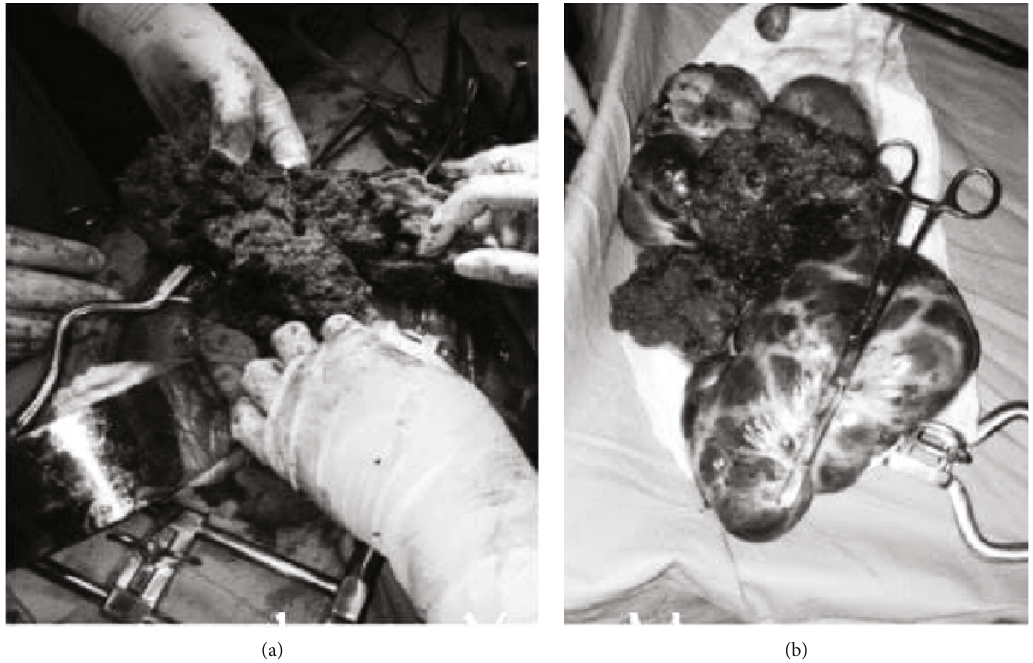
Figure 1: Gross appearance of choriocarcinoma intraoperatively (a) and with cyst after excision (b).